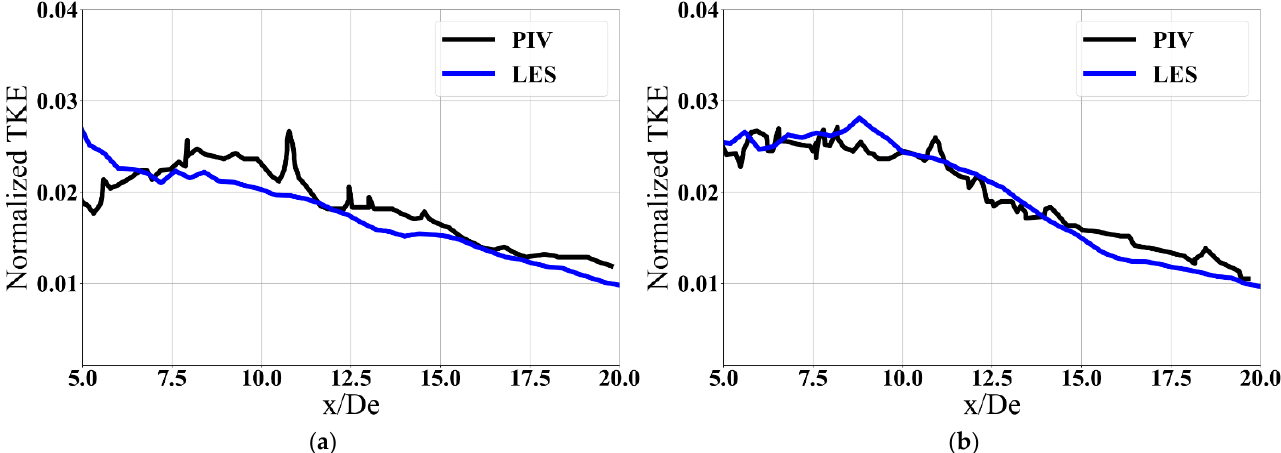
Figure 4. Normalized (by u 2 ) TKE comparison with PIV experimental data from Baier et al. [45]. ( a ) LEScold —minor axis plane, ( b ) LEScold —major axis plane.